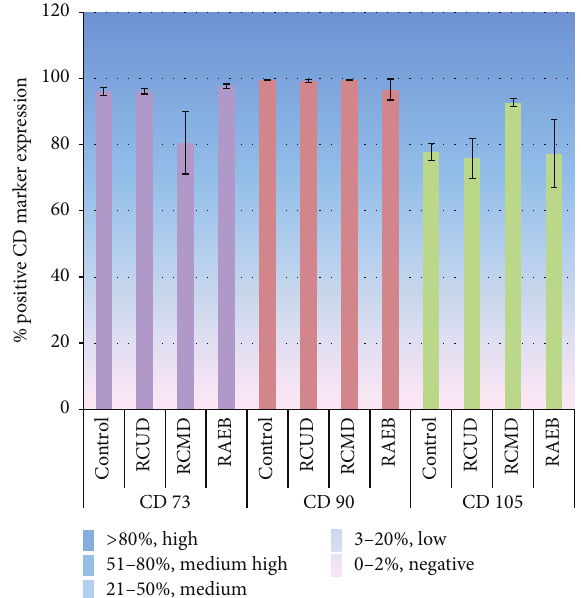
Figure 2: Expression of positive CD markers of culture-expanded P2 MSCs analyzed by flow cytometry. Results were analyzed accord- ing to the subtypes: RCUD ( 𝑛 = 6 ), RCMD ( 𝑛 = 4 ), RAEB ( 𝑛 = 3 ), and controls ( 𝑛 = 3 ). Bar graphs represent the mean % of positive cells ± standard error. The expression profile was categorized as follows: negative: 0–2%, low: 3–20%, medium 21– 50%, medium high: 51–80%, and high: > 80%. All MSCs isolated from controls and MDS subtypes showed high positivity for